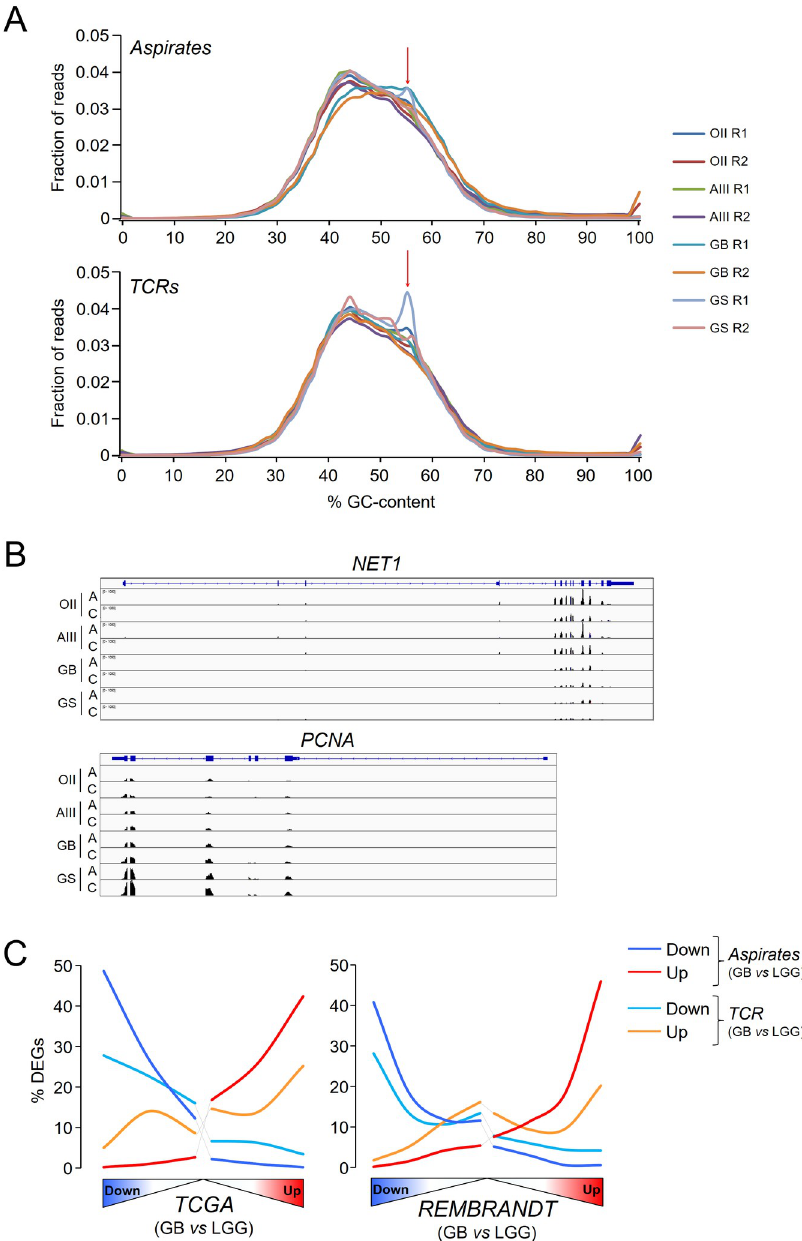
Fig 2. Transcriptomics analysis can be performed using FFPE glioma samples. A , Distribution of GC-content across reads in the FFPE samples used in the study. Because of the paired-end sequencing, each sample produced two fastq files, R1 and R2. The red arrow indicates a secondary aberrant peak. B , Representative RNA-seq tracks for a downregulated gene ( NET1 , neuroepithelial cell transforming gene 1 ) and an upregulated gene ( PCNA , proliferating cell nuclear antigen ) in grade IV tumours related to lower grade gliomas (LGG, II/III). C = tumour core resection. A = cavitational ultrasonic surgical aspirate. B , In the upper panels, percentages of DEGs between grade IV and lower- grade gliomas in the FFPE samples across the whole GB transcriptomes from the TCGA and REMBRANDT cohorts. These transcriptomes were ranked according to the significance and direction of the gene expression change compared to lower-grade gliomas and divided into bins of 2000 genes. The number of DEGs in each bin was then counted and referred to as a % of the total number of DEGs. All distributions were significantly different from random distribution of DEGs ( χ 2 , P <